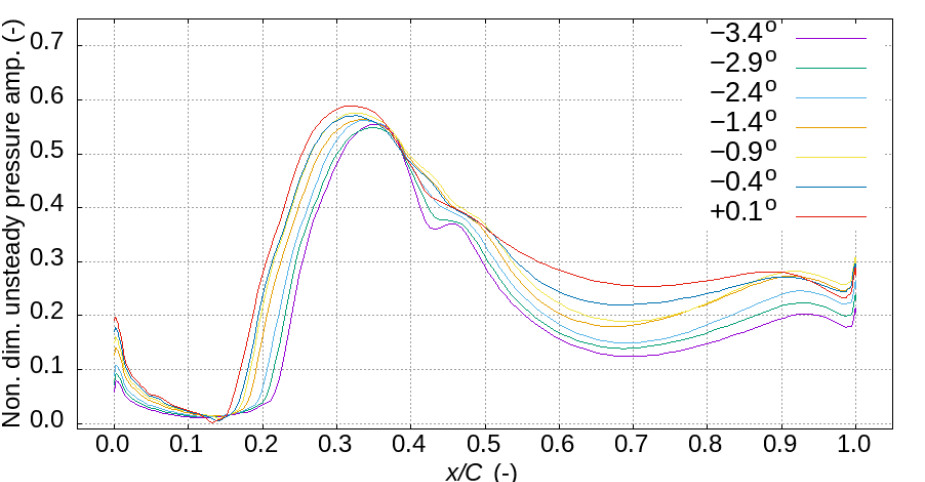
Figure 13. Profiles of Fourier-decomposed unsteady pressure amplitudes on the OGV suction surface for varying β